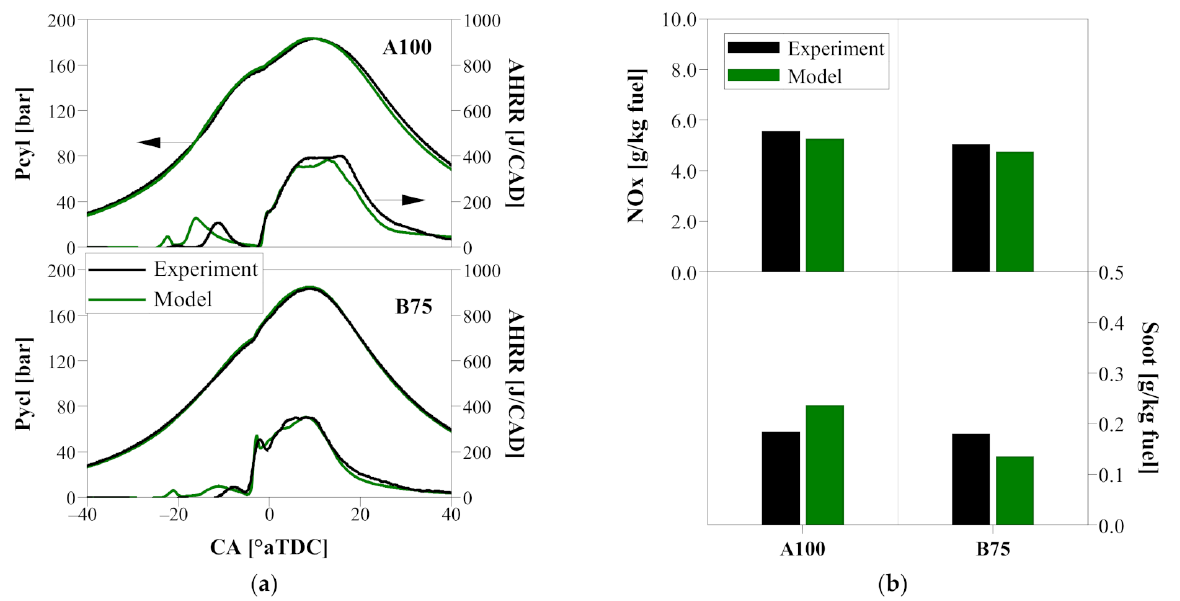
Figure 9. Comparison between experimental data and model predictions: ( a ) cylinder pressure (Pcyl); ( b ) NOx and